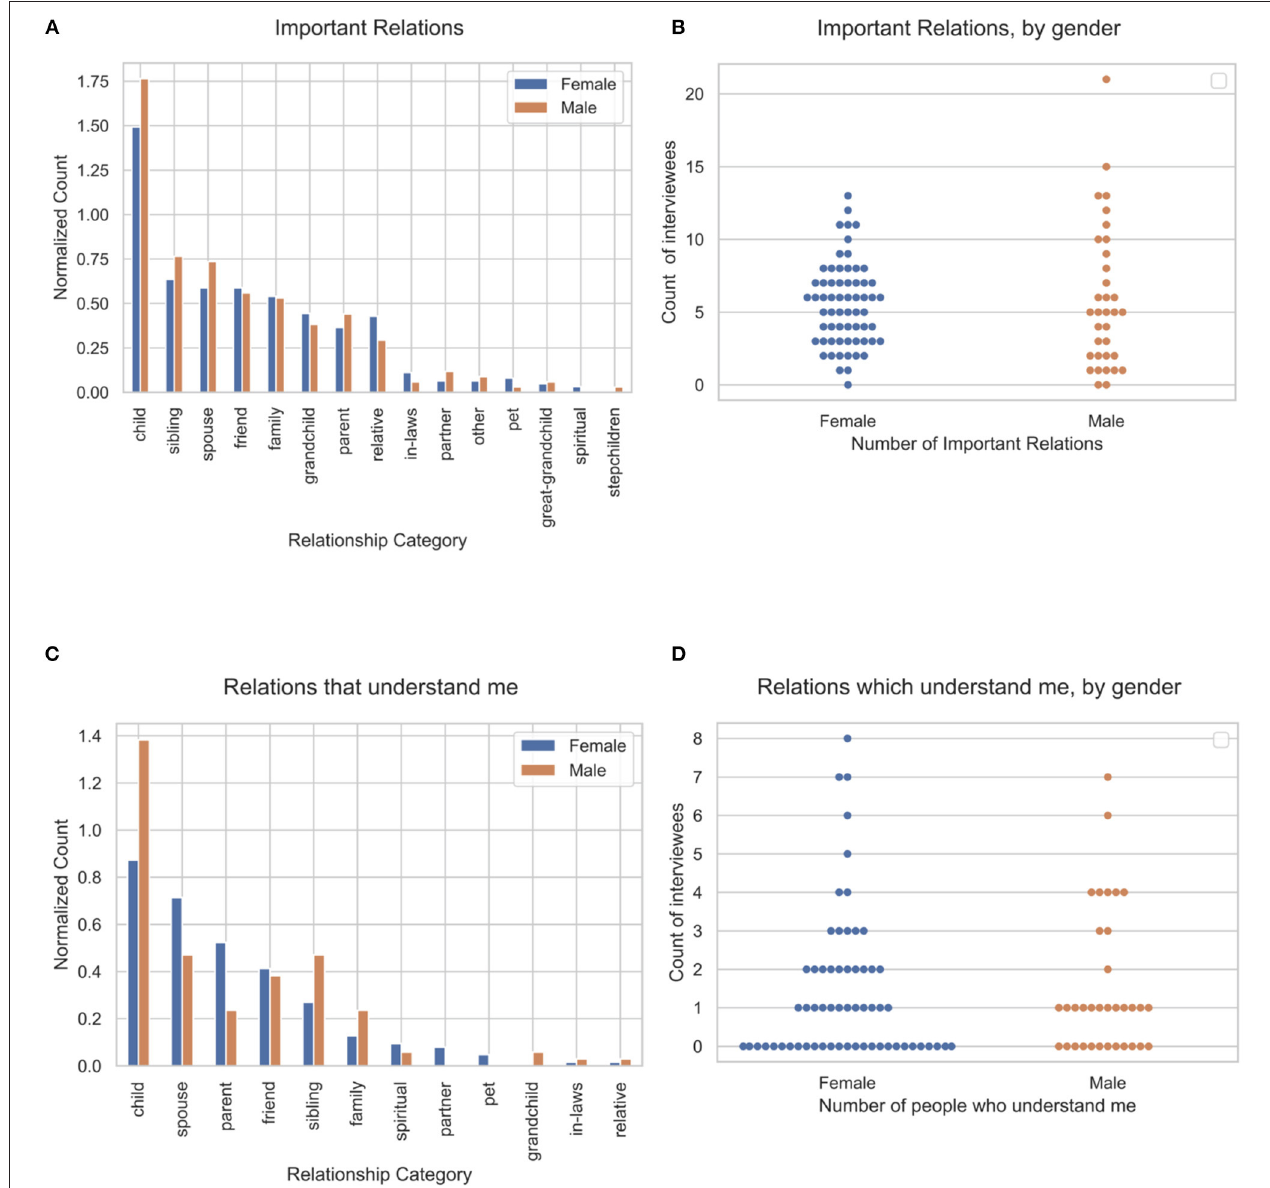
FIGURE 2 | Number and type of important relationships and relationships in which one feels understood. (A) Relationship category, (B) no significant difference in the distribution of the counts by gender, (C) relations that understand in response to Q3, and (D) no significant difference in the distribution of the counts by gender.